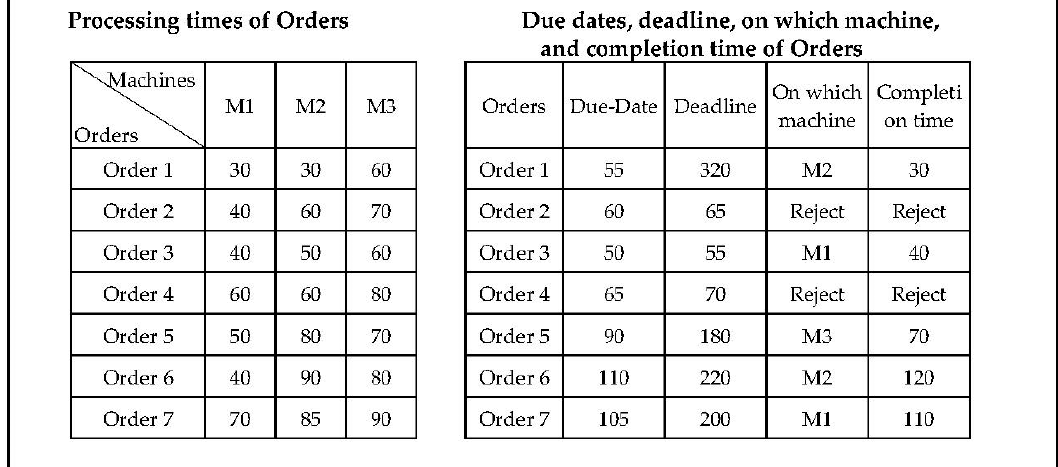
Figure 2. The data of the example for solution encoding.